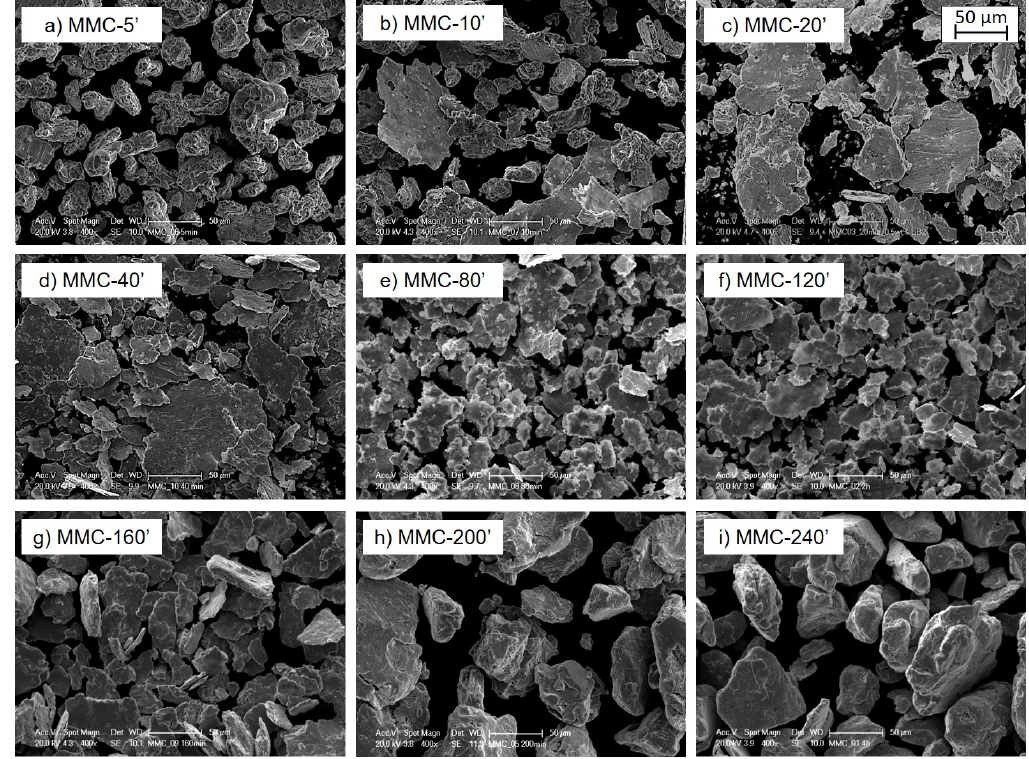
Figure 2. SEM micrograph of MMC powders after different milling times: ( a ) 5 ′ , ( b ) 10 ′ , ( c ) 20 ′ , ( d ) 40 ′ , ( e ) 80 ′ , ( f ) 120 ′ , ( g ) 160 ′ , ( h ) 200 ′ and ( i ) 240 ′ . ( e ) 80 (cid:48) , ( f ) 120 (cid:48) , ( g ) 160 (cid:48) , ( h ) 200 (cid:48) and ( i ) 240 (cid:48)